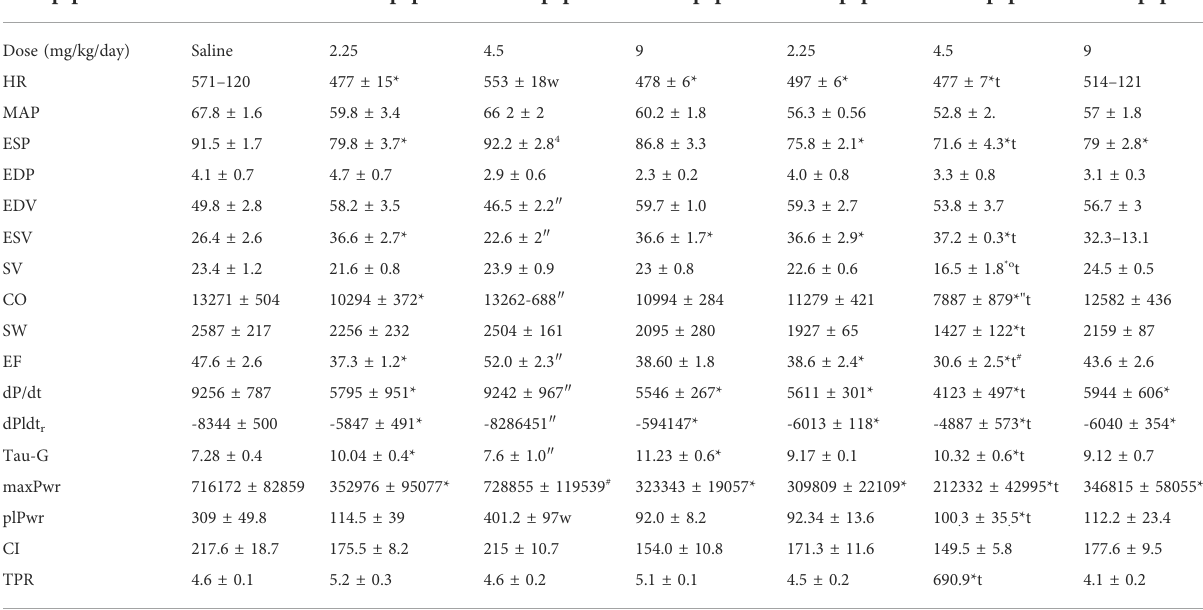
TABLE 1 Cardiac function in mice with either S/A 18 or S/E 18 modi fi ed MGF E-domain peptide treatment at different doses compared to saline. Pressure-volume loop measurements collected in the closed chest con fi guration. Group parameter